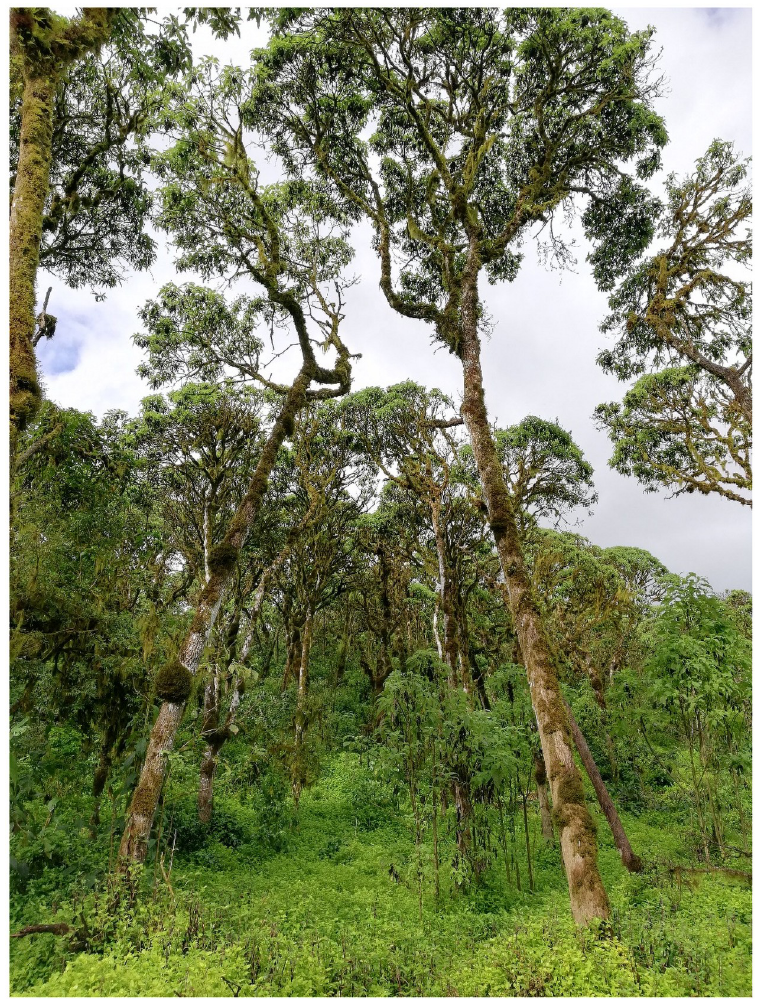
Fig 2. Mature Scalesia pedunculata trees in 2019 with saplings and young trees in the understory in a 6 ha study area in which invasive plant species, especially Rubus niveus , had continuously been removed by the Galapagos National Park Directory since 2014. The plant cover on the forest floor mainly consisted of the invasive carpet- forming Tradescantia fluminensis .